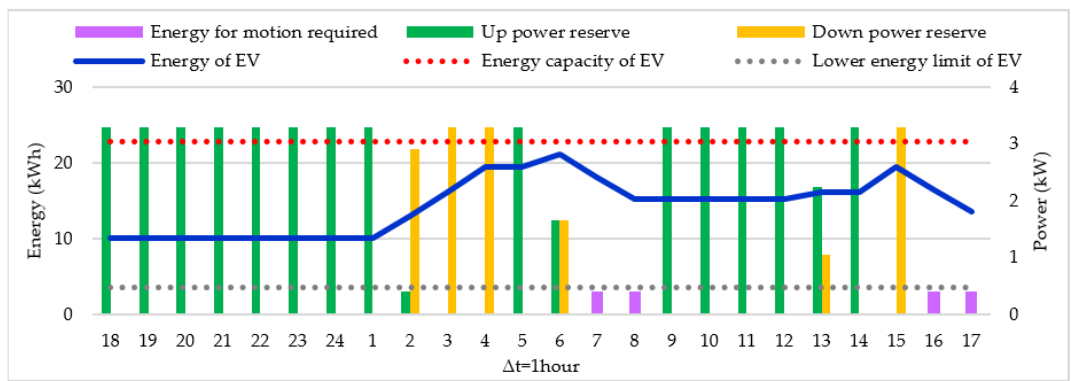
Figure 7. Charging behavior and offers of reserve services of EV # 4 on weekend.